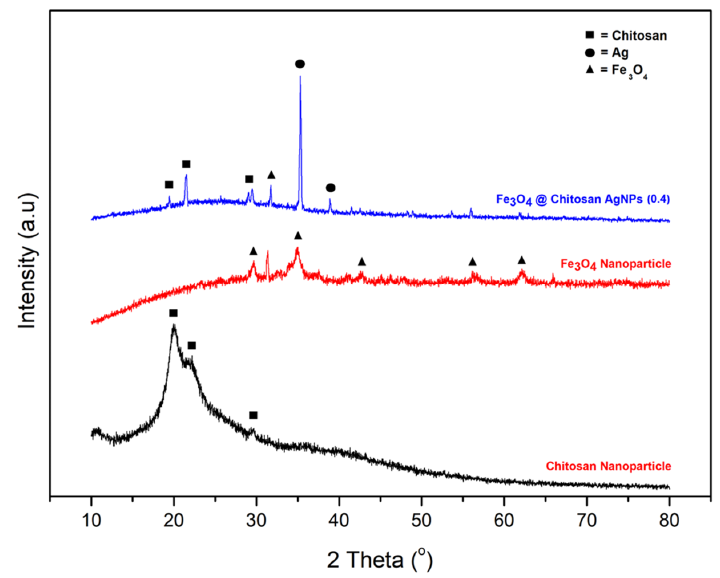
Figure 1. X-ray diffractogram pattern of chitosan, Fe 3 O 4 nanoparticles and Fe 3 O 4 @Chitosan-AgNP nanocomposites.